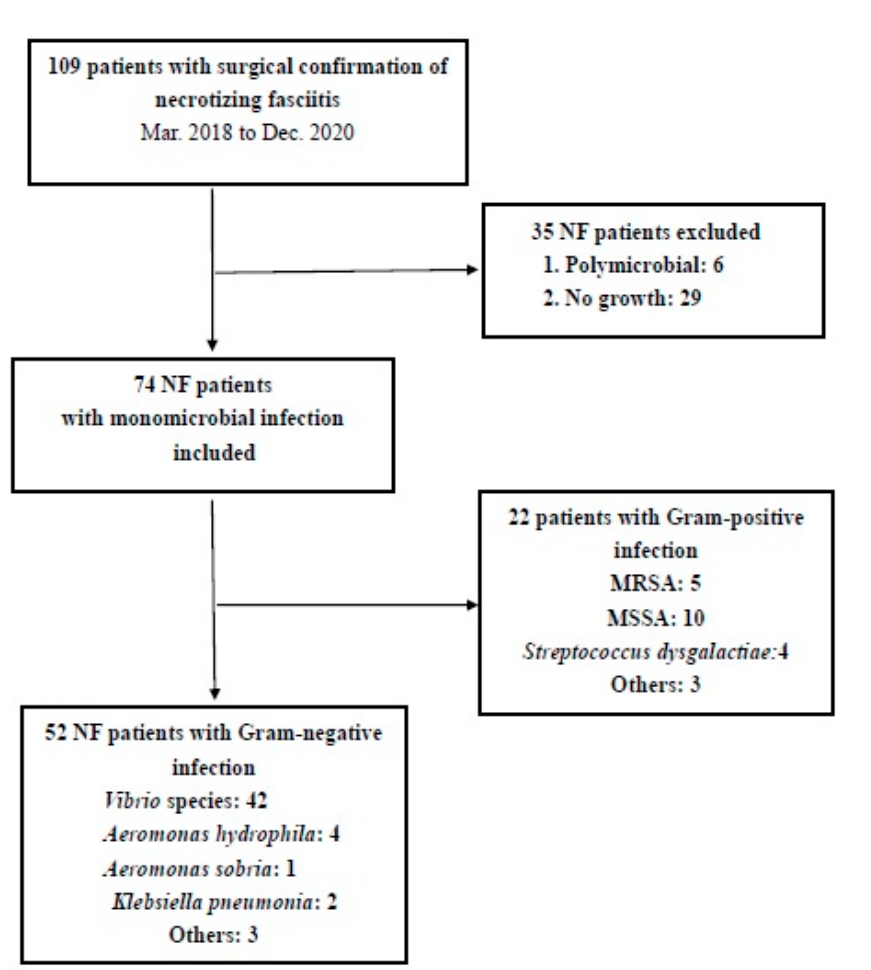
Figure 1. Flow chart of NF patient inclusion.